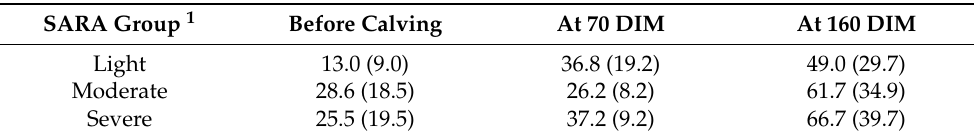
Figure 4. ( a , b ) Boxplot graphs illustrating the increase in CCS values from hoof trimming visit 1 to visit 3 in the cows of the SARA groups light, moderate and severe; the left boxplot ( a ) includes the data of all claw lesions; in the right boxplot ( b ) the proportional data of heel horn erosion (HHE) were omitted, which clearly scaled down the CCS values (see the y axis); *–***: indicates significant differences between hoof trimming visits. Table 5. CCS means of the cows of the three SARA groups at the three hoof trimming visits; the numbers in parentheses indicate the mean CCS values without inclusion of the proportional data of heel horn erosion